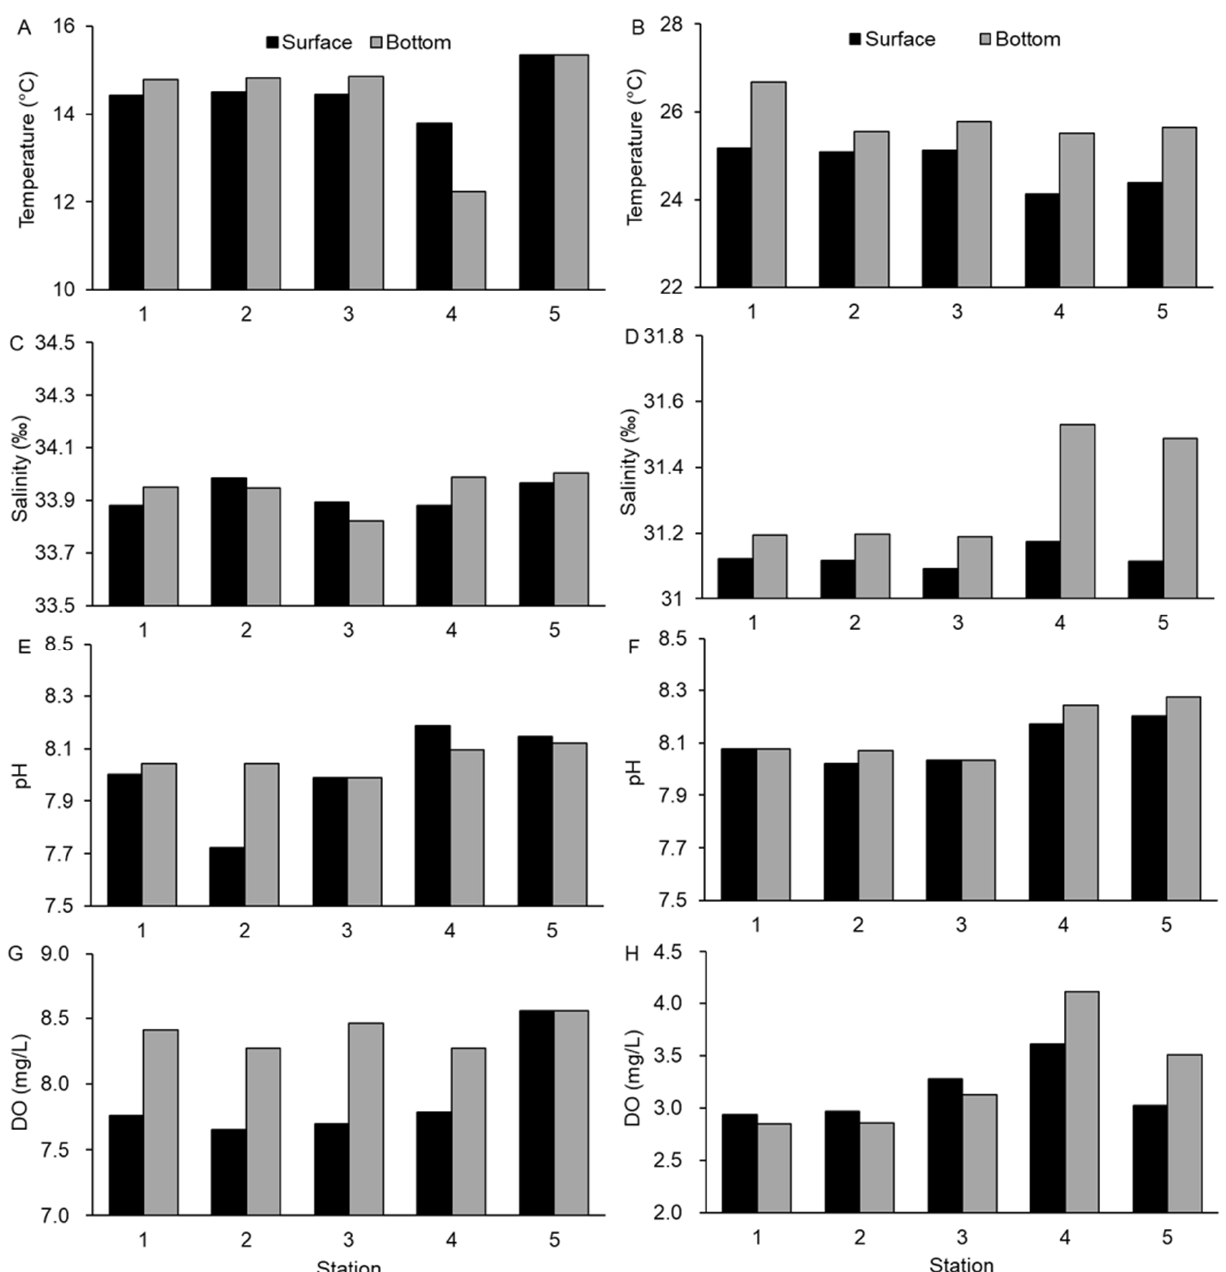
Figure 2. Water quality variables during the sampling period. ( A ) Water temperature (°C) in May, ( B ) Water temperature (°C) in September, ( C ) Salinity (‰) in May, ( D ) Salinity (‰) in September, ( E ) pH in May, ( F ) pH in September, ( G ) dissolved oxygen (DO; mg/L) in May, ( H ) DO (mg/L) in September. Circles denote water quality in the surface water, and squares denote water quality in the bottom water.